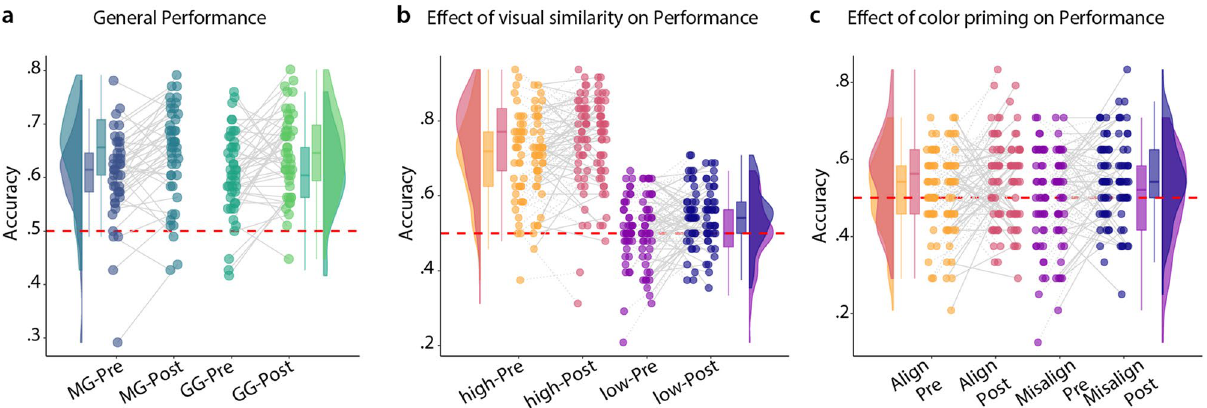
Figure 6. Results from the forced choice task investigating visual similarity and colour priming. ( a ) General performance split up by groups and time point: pre or post. Mixed ANOVA revealed a main effect of time- point but not of group. ( b ) Main effect of visual similarity on performance. Violin and bar plots contain data from both groups. Scatter plots in each condition are split into two columns: the first column for the movement group, the second for the gamepad group. There was no main effect of group. Lines connect individual measures. ( c ) Illustration of the absence of an effect of colour priming in the data. As in ( b ), the two columns of identically coloured scatter dots illustrate participants’ performance in the movement group and the gamepad group respectively. Note that only trials in the low-visual similarity condition were used in this analysis, therefore fewer trials factored into the